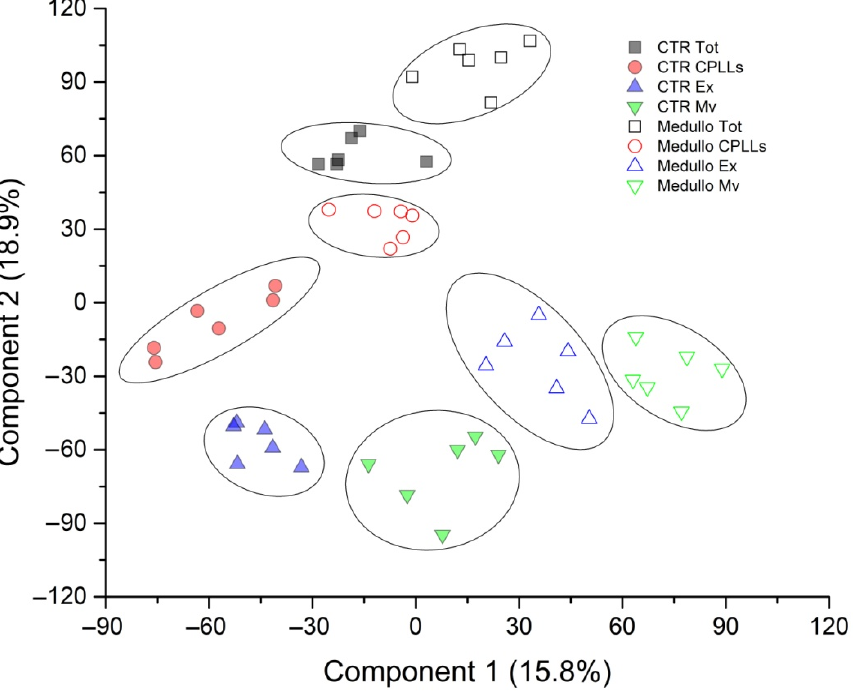
Figure 4. Partial Least Square Discriminant Analysis (PLS-DA) of all proteins identified in CSF from the EVD of MB and control samples. Two-dimensional scatter plot of PLS-DA showing the supervised cluster analysis of all proteins identified in CSF from the EVD of MB (open symbols) and control (solid symbols) in the total (black squares), CPLL (red circles), Mv, and Ex of the two clusters. PLS-DA identified eight clusters corresponding to the two clinical groups in each fraction.